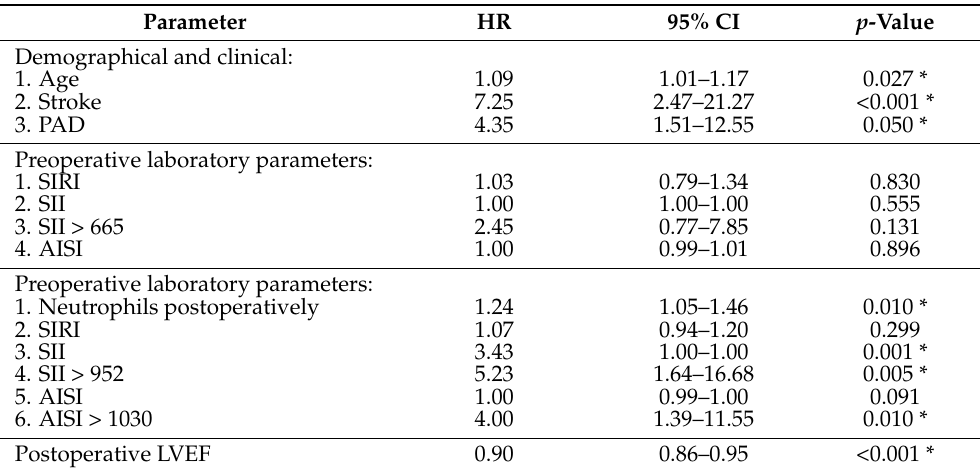
Table 4. Cox regression univariable analysis for long-term survival.